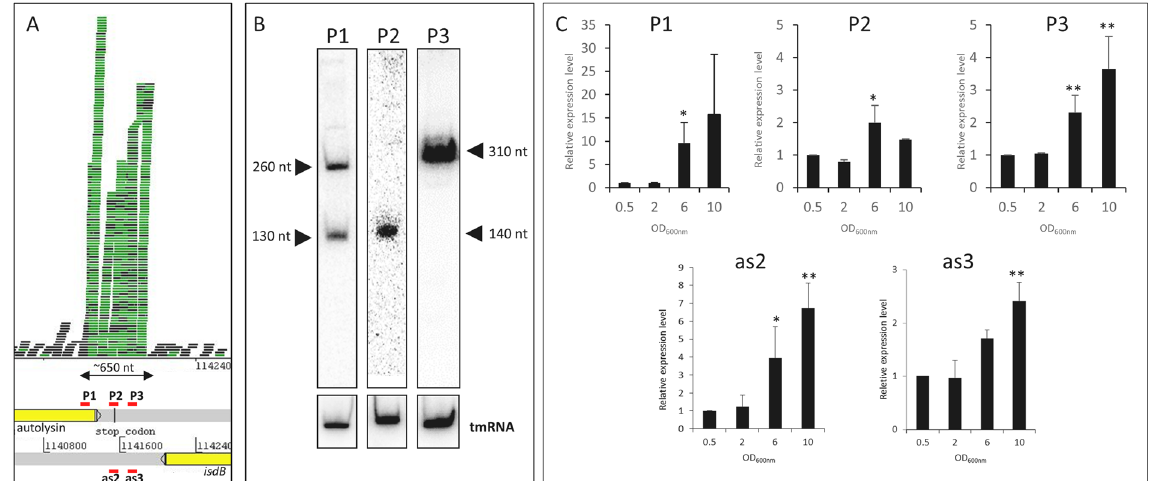
Figure 3. Characterization of an sRNA transcription hotspot in Staphylococcus aureus Newman. ( A ) RNA mapping profile of IGR_11415444 visualized with Artemis. P1, P2, P3, as2, and as3 correspond to the position of probes and/or primers for northern blot and RT-qPCR experiments. ( B ) Identification of multiple transcripts expressed from the positive strand of the Newman genome. Total RNA were extracted from cells collected